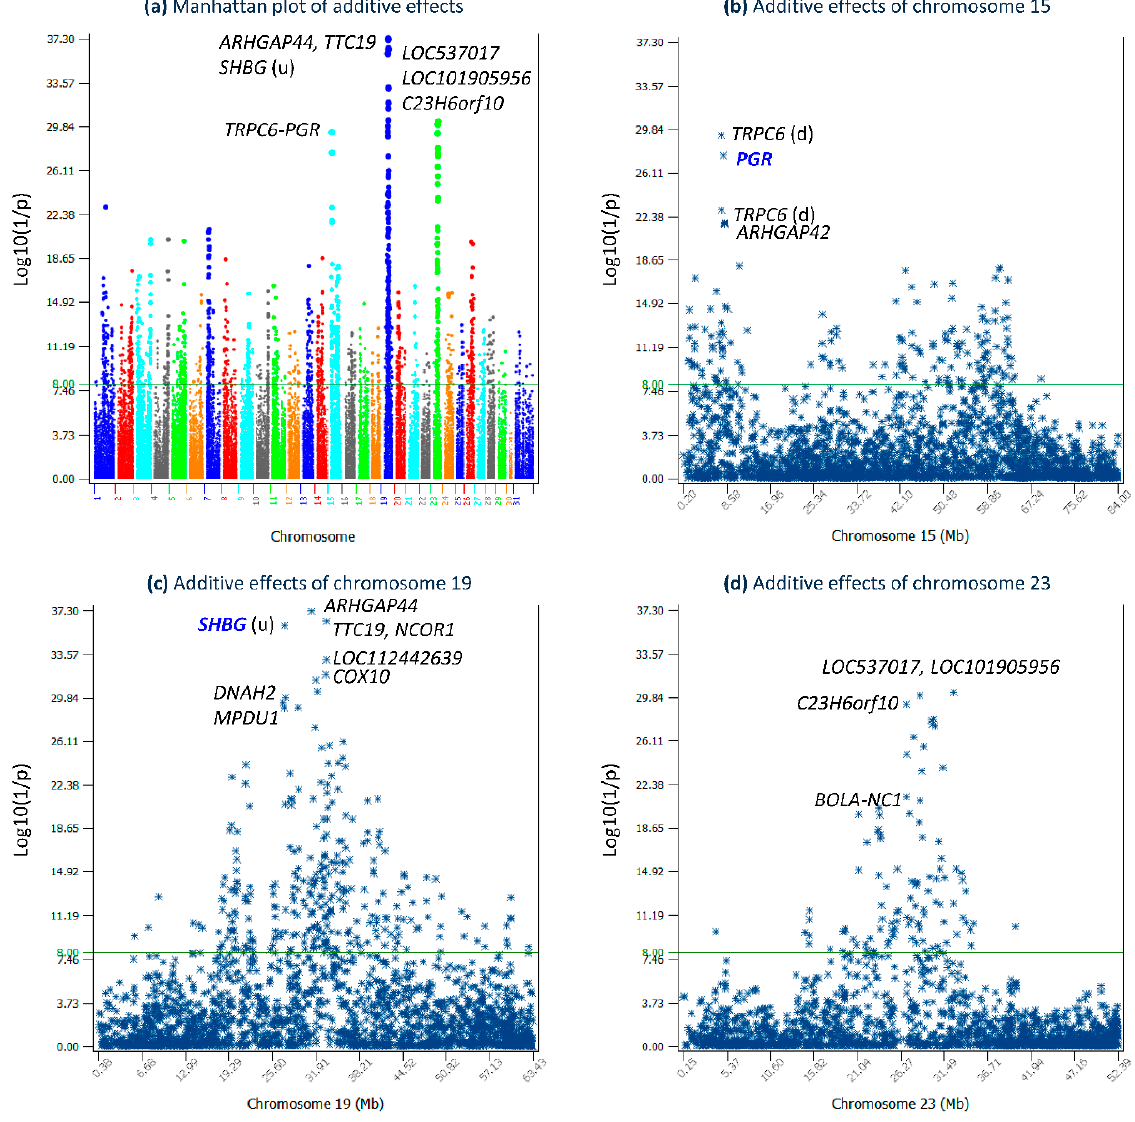
Figure 1. Graphical view of additive effects. ( a ) Manhattan plot of additive effects of all chromosomes. ( b ) Additive effects of chromosome 15. ( c ) Additive effects of chromosome 19. ( d ) Additive effects of chromosome 23. ‘u’ indicates the SNP is upstream of the gene, and ‘d’ indicates the SNP is downstream of the gene.